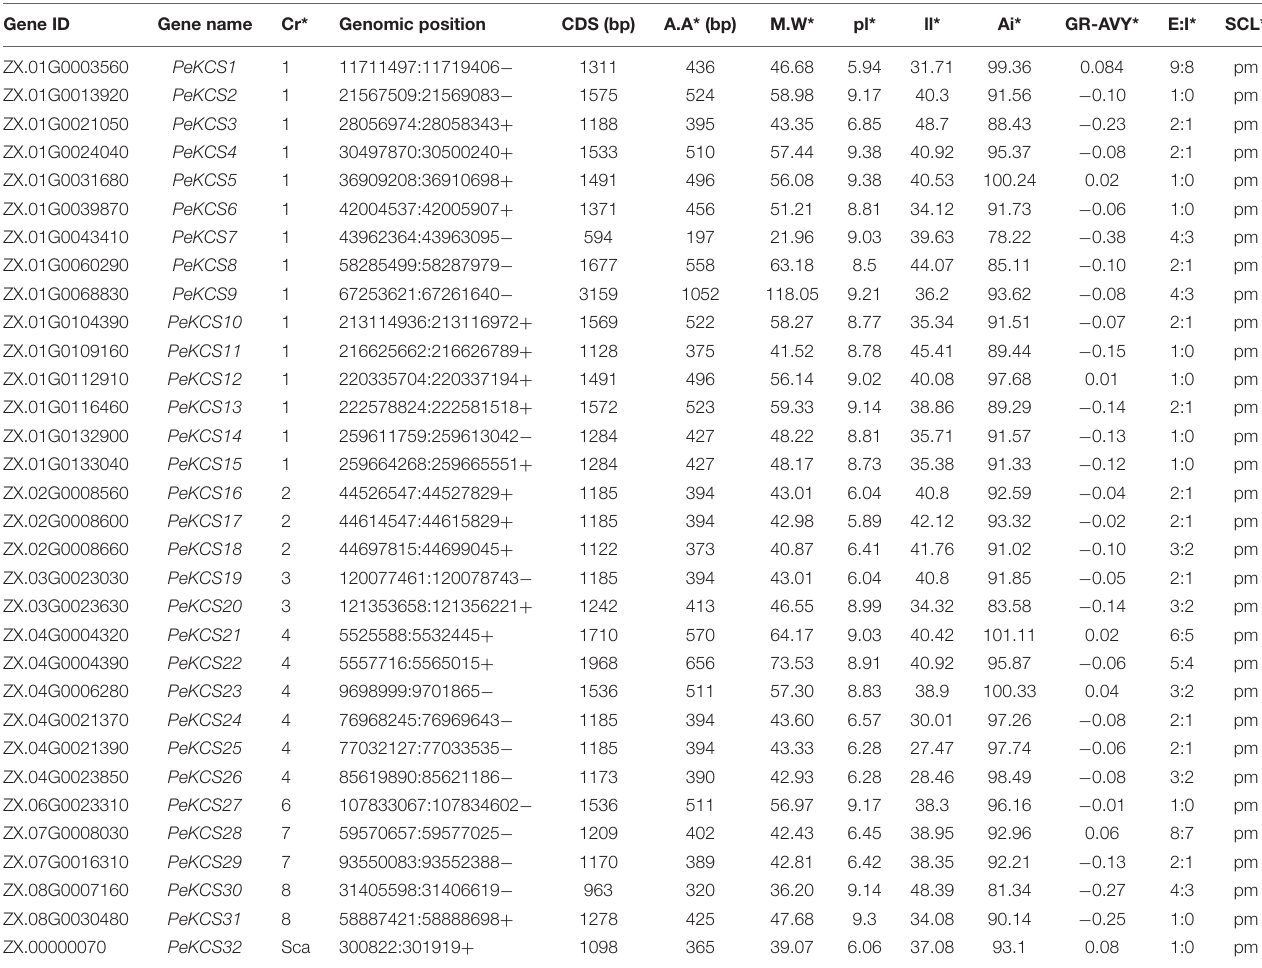
TABLE 1 | Physiochemical properties of PeKCS